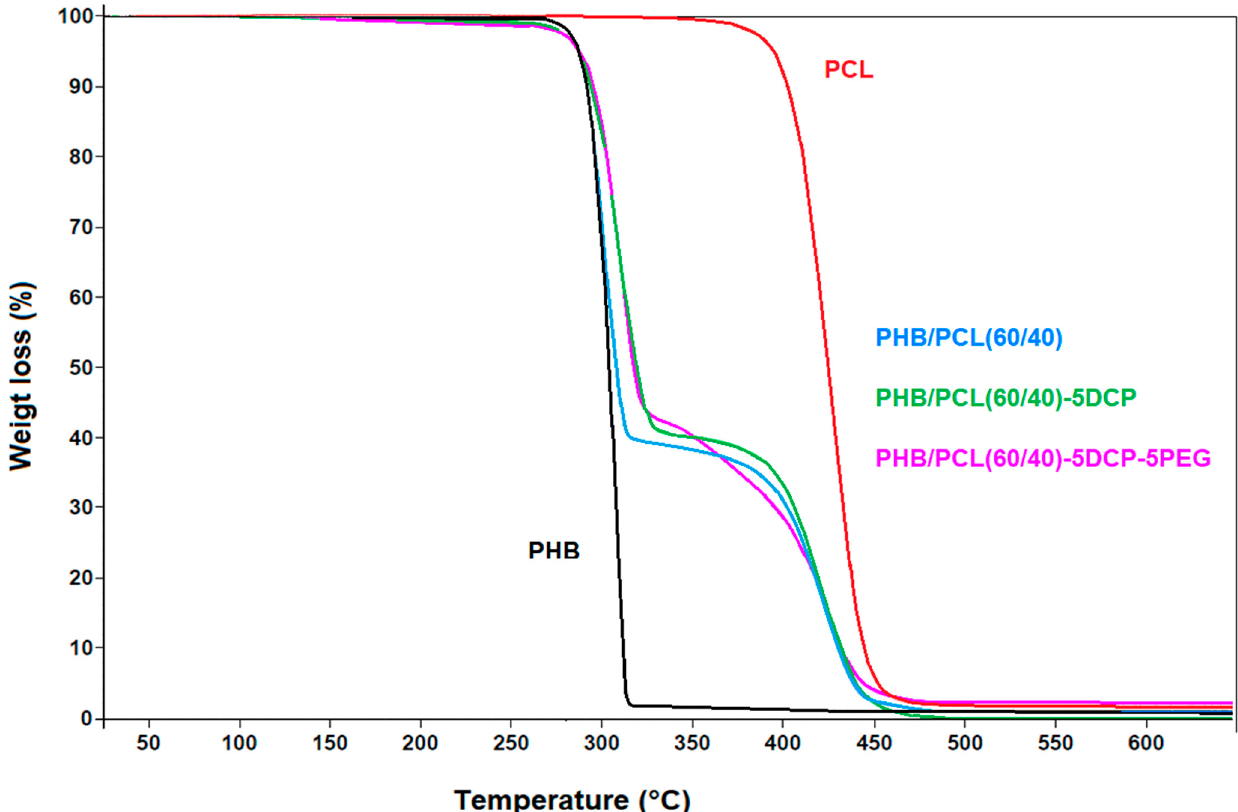
Figure 2. TGA thermograms of PHB, PCL and their blends (TGA analysis under N 2 ). Table 4. Degradation temperature of PHB, PCL, and PHB/PCL blends.